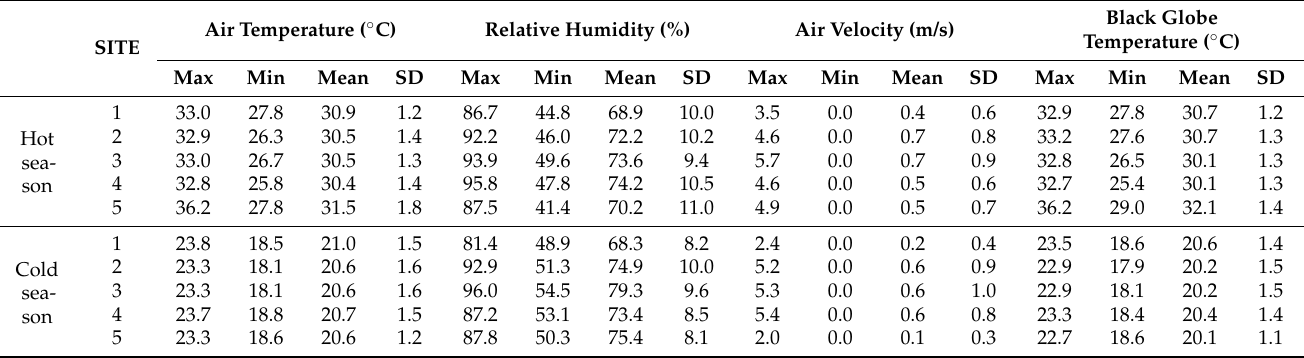
Table 5. Thermal environment at each measurement site.